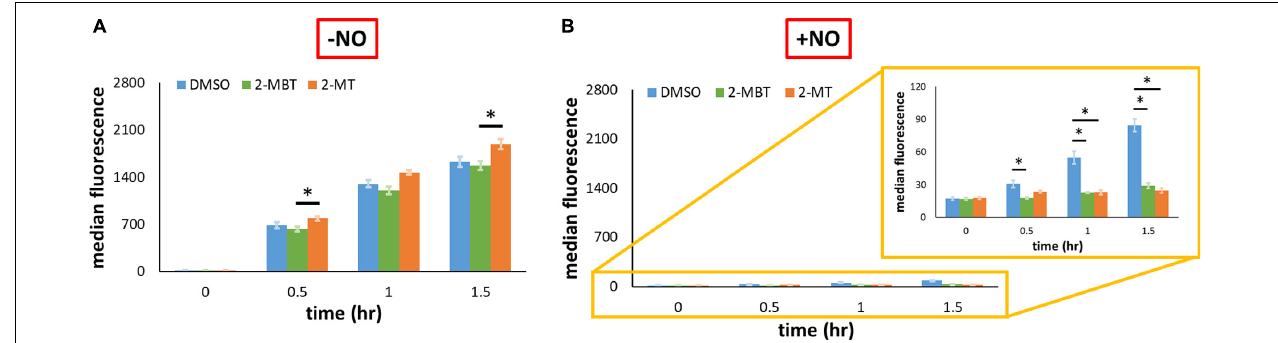
FIGURE 9 | Protein output from P T 5 in the presence and absence of NO with and without inhibitors. gfp SF was under the regulation of an IPTG-inducible P T 5 promoter on pUA66. At time = 0, 2 mM IPTG were added to allow the full induction of expression, and protein abundance in the absence of NO (A) or in its presence (B) was measured by fluorescence via flow cytometry. Solid bars are the mean of the median fluorescence of 100,000 cellular events from 3 biological replicates, and the error bars the standard errors of the means. Asterisk signs (*) indicate when the fluorescence between compared groups were significantly different. Statistical significance was determined by first running a one-way ANOVA test across all treatment conditions at the same time point. When the p -value from the ANOVA test was lower than 0.05, difference between groups were assessed by performing Tukey’s test, with a p -value threshold of 0.05.